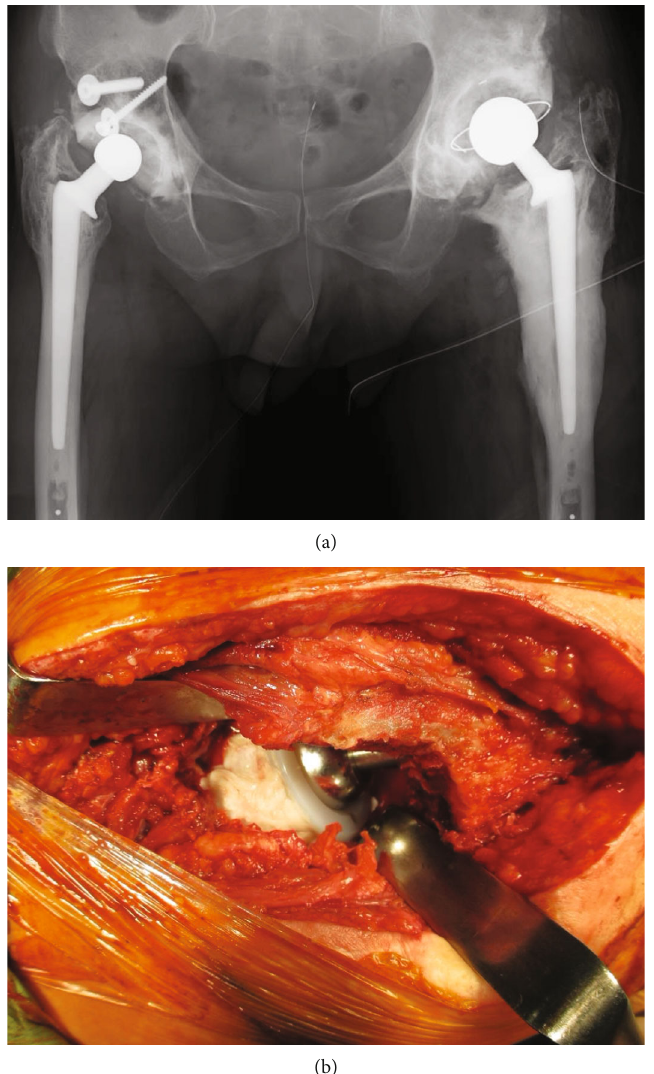
Figure 3: (a) Plain radiograph obtained immediately after the revision THA (second THA) in a 78-year-old man. Abbreviations: THA: total hip arthroplasty. (b) Owing to limited surgical fi eld for a joint revision procedure in a 78-year-old man, using the standard approach because of hip ankylosis, the cement and polyethylene liner were placed onto the acetabulum after impaction of the new